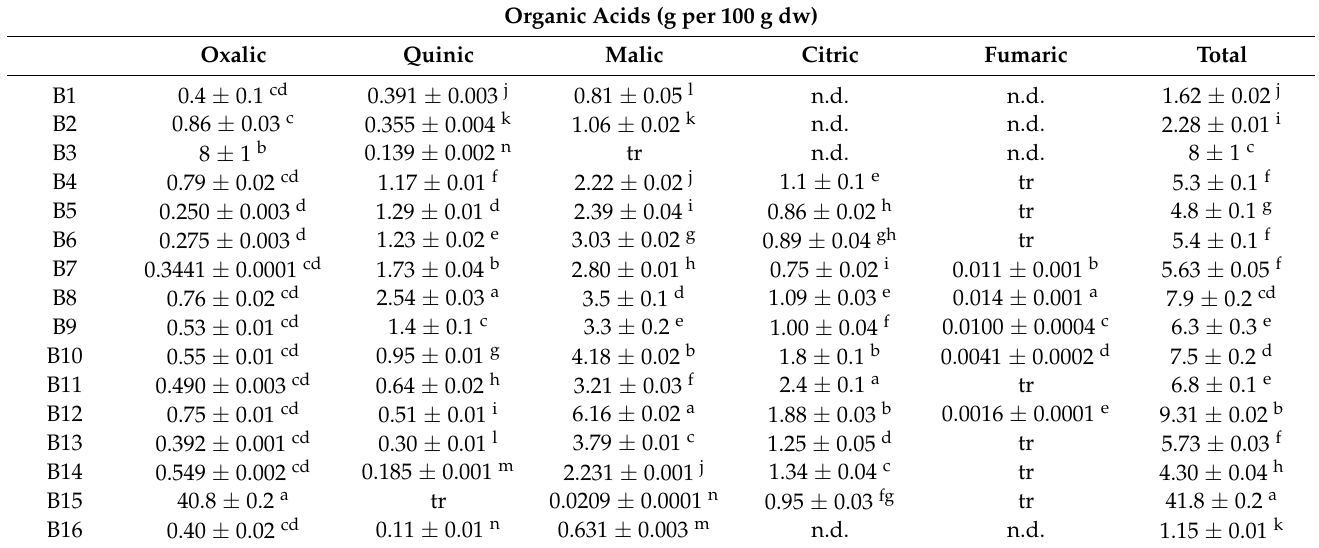
Table 4. Organic acids identified on Cynara cardunculus L. blades collected at different growth stages. Organic Acids (g per 100 g dw) Citric